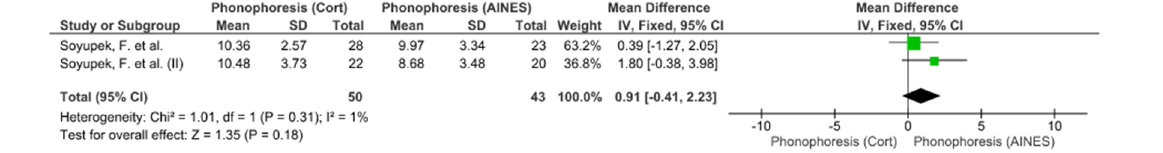
Figure 12. Phonophoresis for CMAPam.